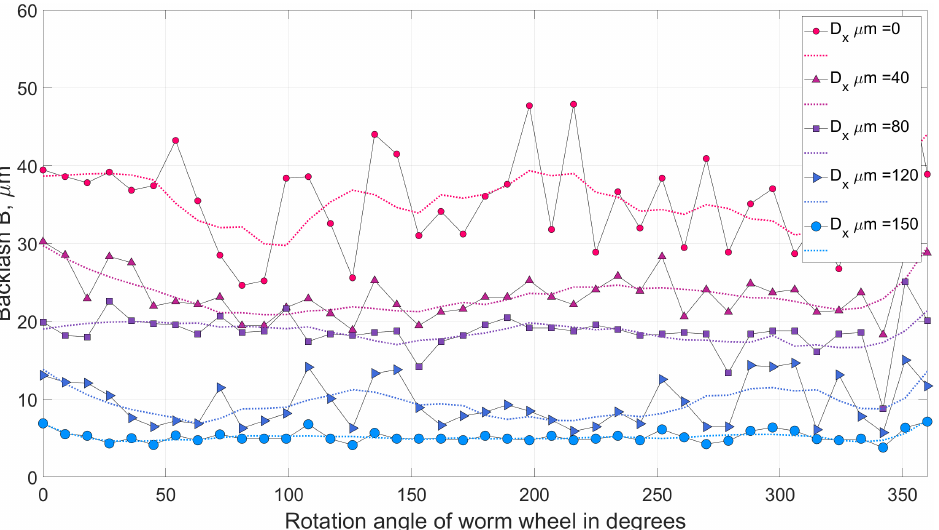
Figure 14. Backlash B adjustment results for WG1 worm gear drive for different values of adjustment settings D x ∈ {0, 40, 80, 120, 150} µ